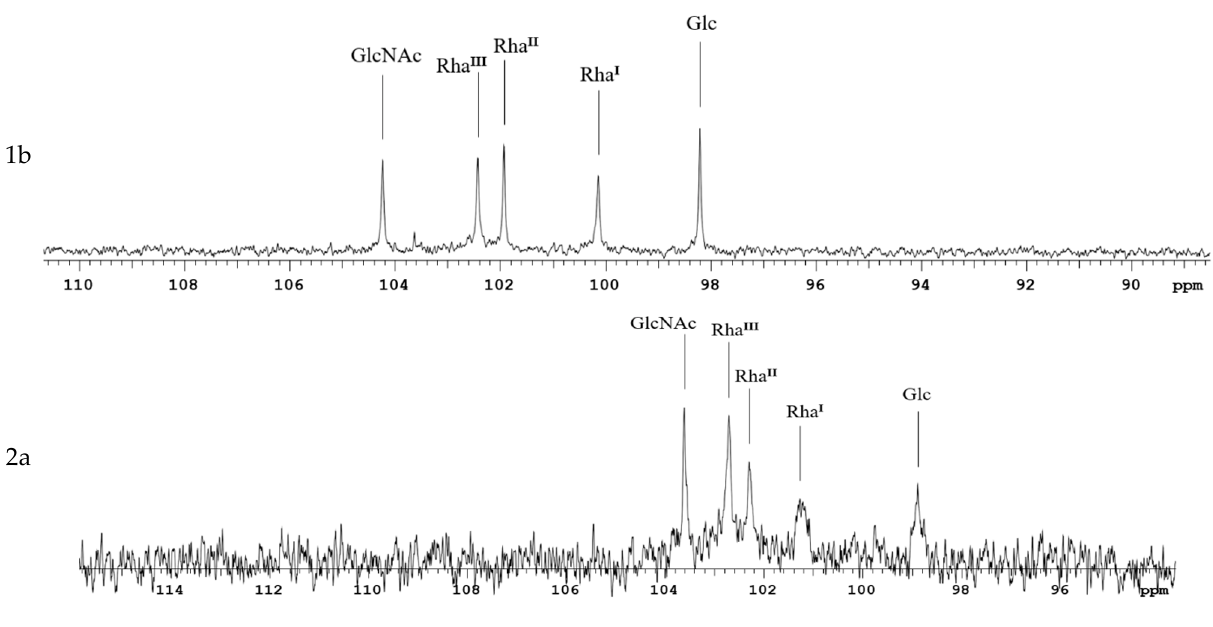
Figure 1. Structural analysis of S. flexneri Ac 3 -S-LPS isolated from serotypes 1b, 2a, 3a, 6, and Y . ( a ) Silver-stained SDS-PAGE was used to determine the length of the O-PS chain and ( b ) negative ion mass spectrometry was used to determine the amount of fatty acids. Lipid A samples were released from the modified S-LPS of S. flexneri by mild acid hydrolysis (2% AcOH, 100 °C, 1 h). The characteristic signals in the anomeric carbon region of the 13 C NMR spectra of S. flexneri Ac 3 -S-LPS do not overlap and are a distinctive feature for each serotype, notably the characteristic rhamnose signals associated with different degrees and positions of O- acetylation. The shifts of anomeric protons were analyzed by comparing the NMR spectra of S. flexneri 1b, 2a, 3, Y, and 6 Ac 3 -S-LPS with the literature data (Figure 2).